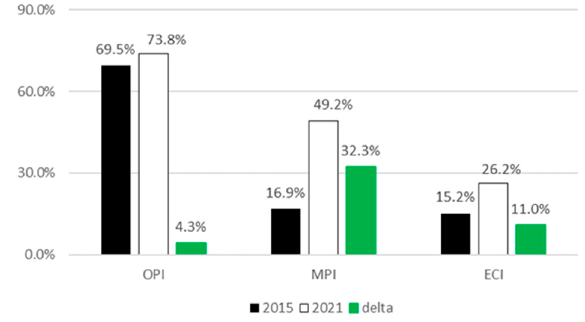
Figure 4. Organisations that monitor other indicators.